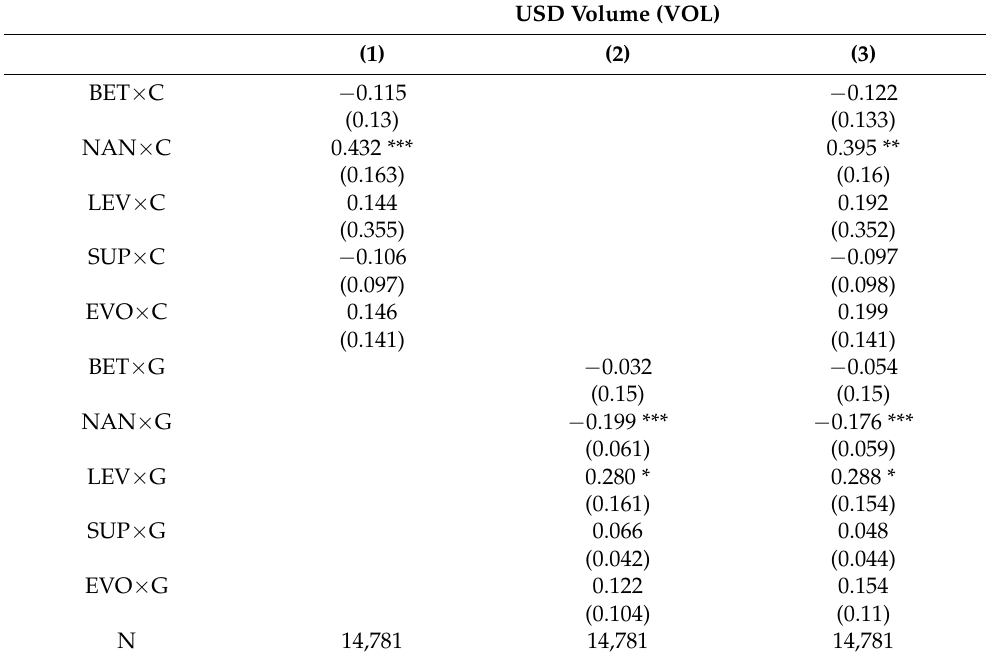
Table 4. Regression results: COVID-19 and Great Financial Crisis. Table 4 contains the estimated regression coefficients for the interaction terms that have been added to equation (1) as described in the text. The table only displays the interaction terms. Reading example: The information in the row labeled NAN × C is related to the coefficient of the interaction term of NAN (number of analysts) and C (COVID-19 period dummy) in the regression. The associated standard errors are reported in parentheses. The standard errors are double clustered around both time and firms. ***, **, and * denote significance at the 1%, 5%, and 10% levels,